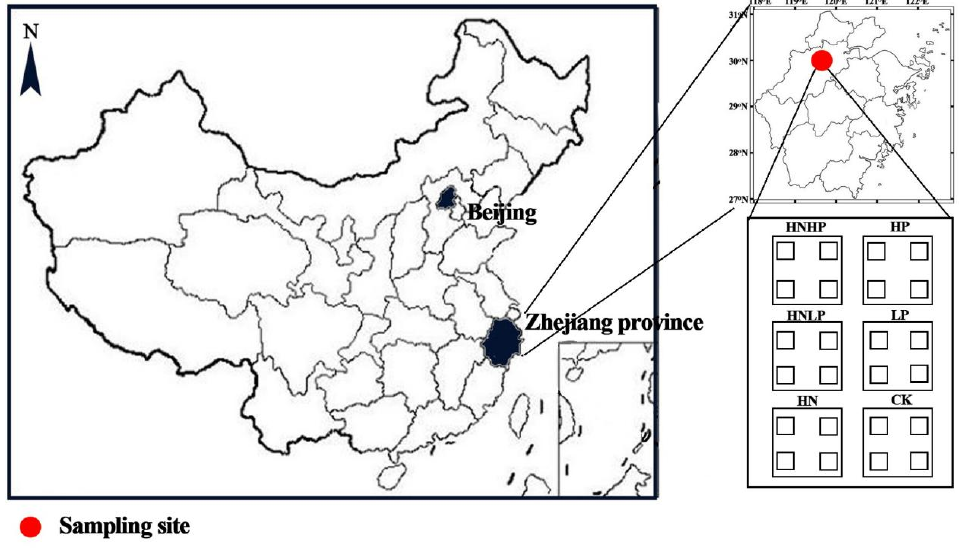
Figure 1. Location of the study area and experimental design (six treatments with four